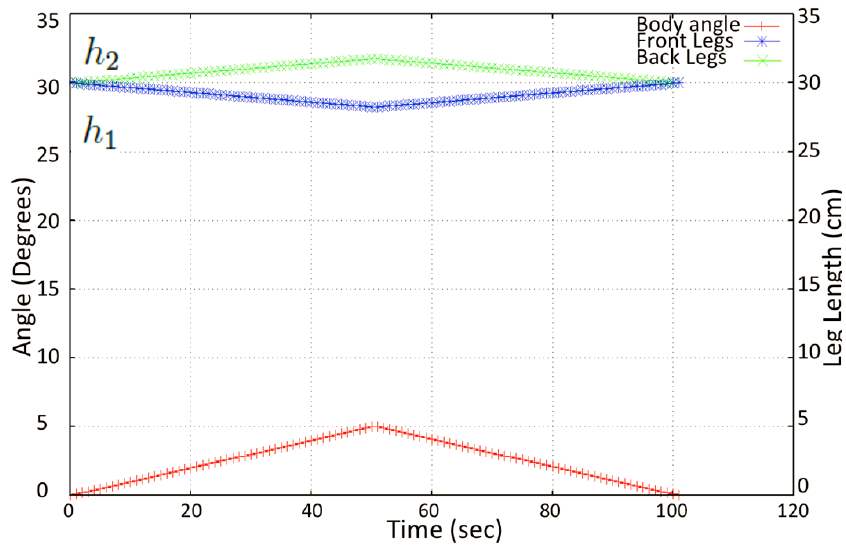
Figure 12. Variation of leg heights ( h 1 and h 2 with respect to the trunk body (pitch angle) obtained upon